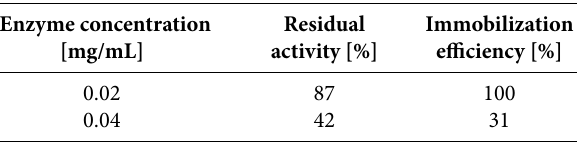
Table 2. Residual activities and immobilization efficiency of ADH immobilized onto epoxy functionalized CMD-MNPs, while investi- gating enzyme concentration.